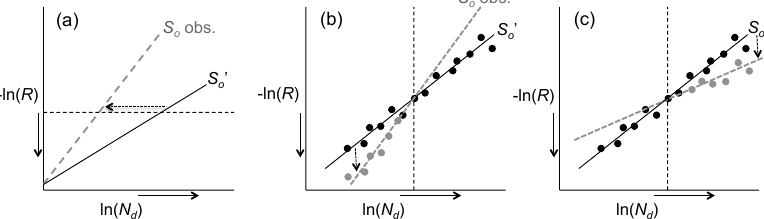
Figure 11. A visual description of (a) the effect of wet scavenging and (b–c) the impact of an increase in rainfall rate for a given range of N d on the estimate of S o . The solid line (with and without black filled circles) represents true (to be expected) S o , whereas the dashed line (with and without gray filled circles) indicates observed (responded) S o . R increases downward on y ordinate and N d increase toward the right direction on x abscissa. The direction of arrows inside the figure indicates the direction of S o